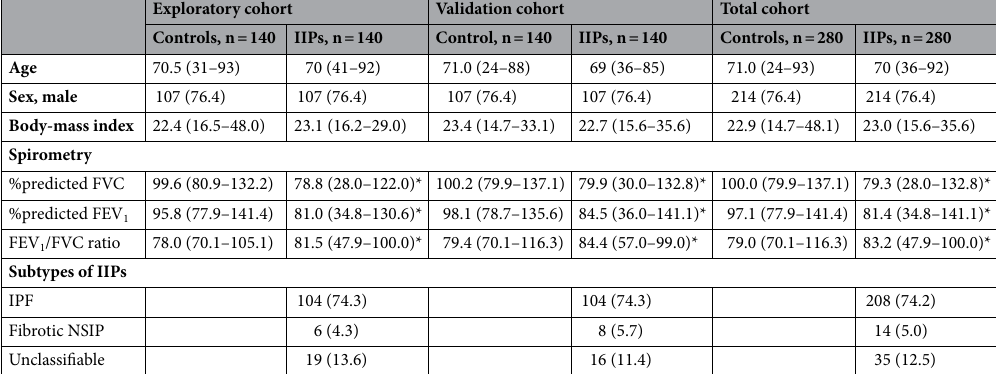
Table 1. Patient characteristics. Data presented as median (range) or number (%). FEV 1 forced expiratory volume in 1s, FVC forced vital capacity, IIPs idiopathic interstitial pneumonias, IPAF interstitial pneumonia with autoimmune features, IPF idiopathic pulmonary fibrosis, NSIP non-specific interstitial pneumonia. * p < 0.001 compared with control subjects in each cohort.